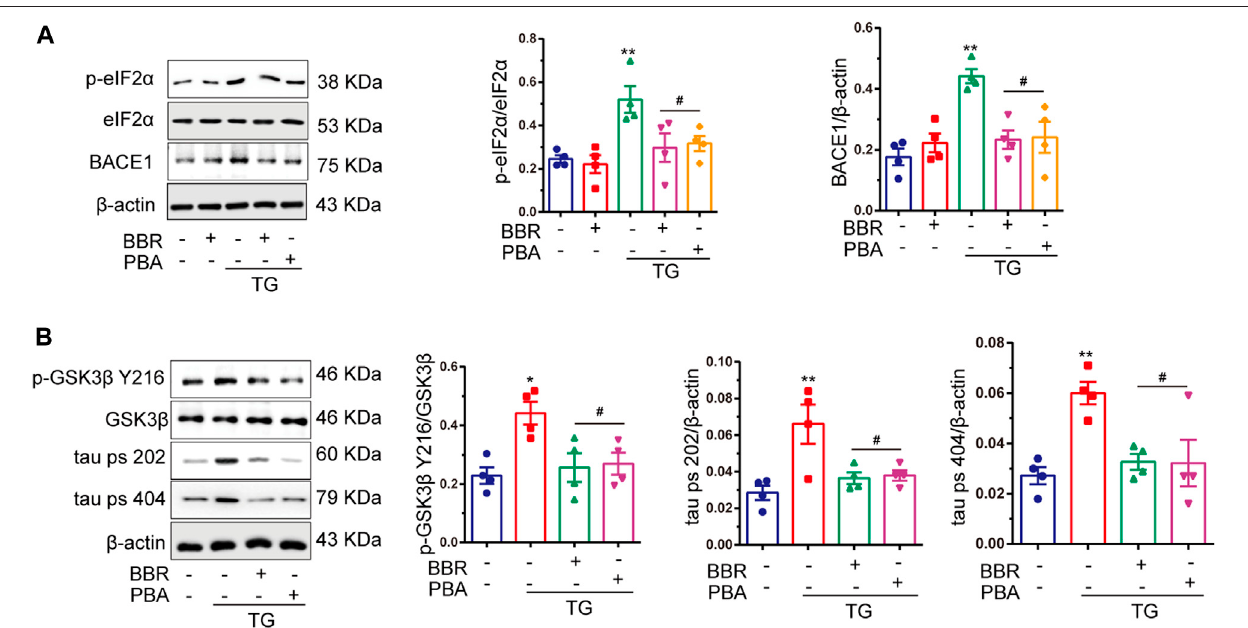
FIGURE 6 | Berberine inhibits tau hyperphosphorylation, as well as BACE1 production and eIF2 α activation. (A) Western blot detection of p-eIF2 α , eIF2 α , and BACE1 inTG-induced HT22/APP cellswith orwithoutPBA orBBR and quantitativeanalysis. (B) Western blot detection ofp-GSK3 β Y216, GSK3 β ,tau ps202, and tau ps404inTG-inducedHT22/APPcellswithorwithoutPBAorBBRandquantitativeanalysis.Datawerepresentedasmeans ± SEM.* p < 0.05,** p < 0.01vs.Blank; # p < 0.05 vs.